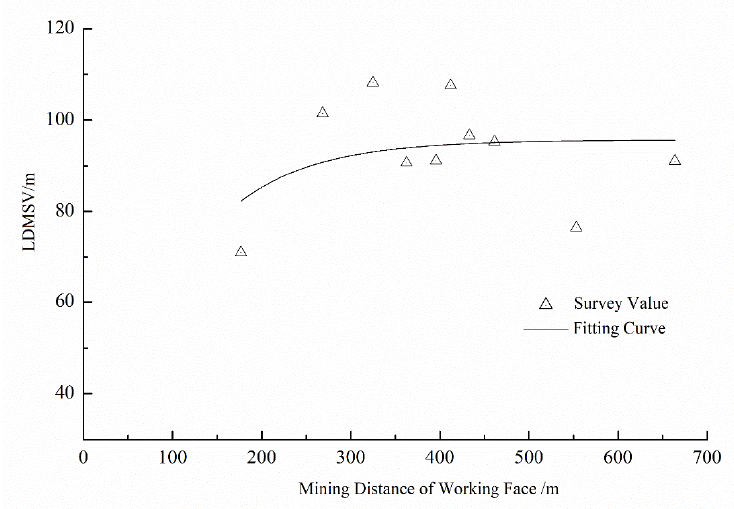
Figure 5. Dynamic curve of lag distance of maximum subsidence velocity (LDMSV).